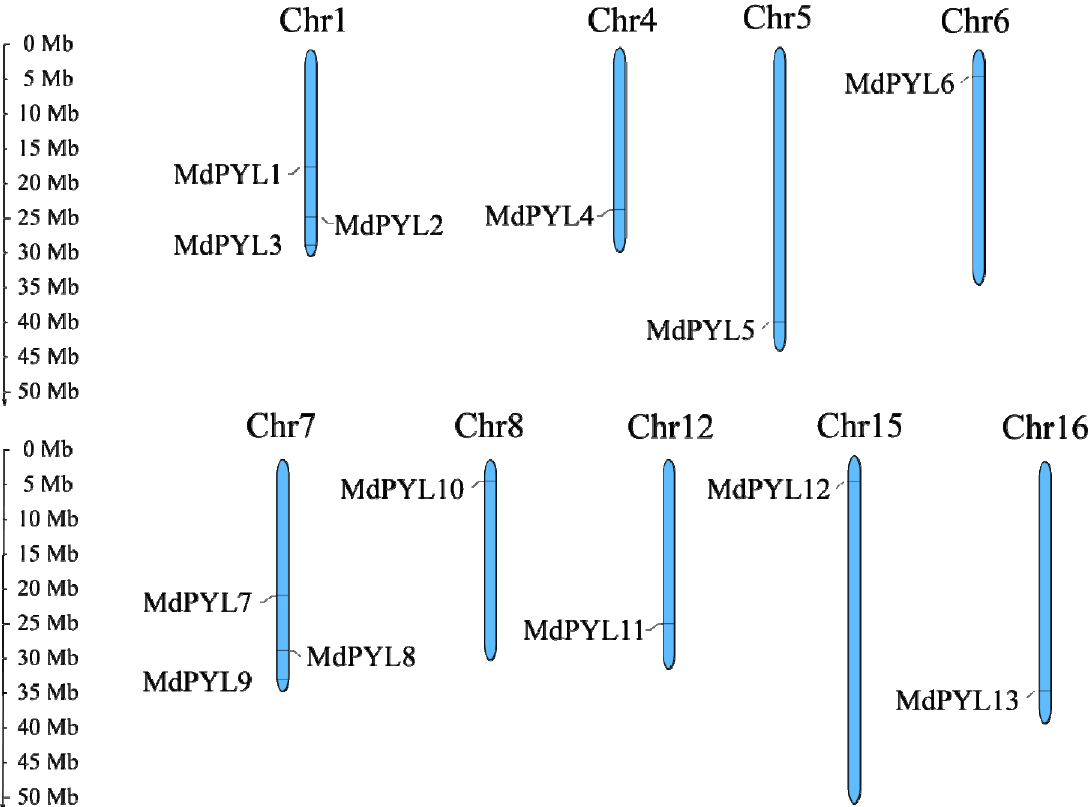
values of these proteins ranged respectively from 20.13 kDa (MdPYL5) to 27.66 kDa (MdPYL4) and